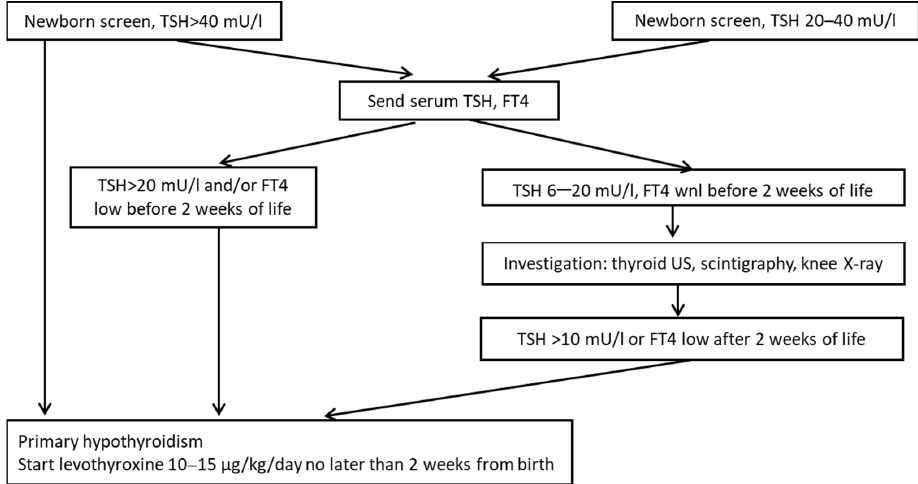
Figure 2. Algorithm for congenital hypothyroidism screening and workup (adapted from Euro- pean Society for. Pediatric Endocrinology. Consensus Guidelines on Screening, Diagnosis, and Management of Congenital Hypothyroidism